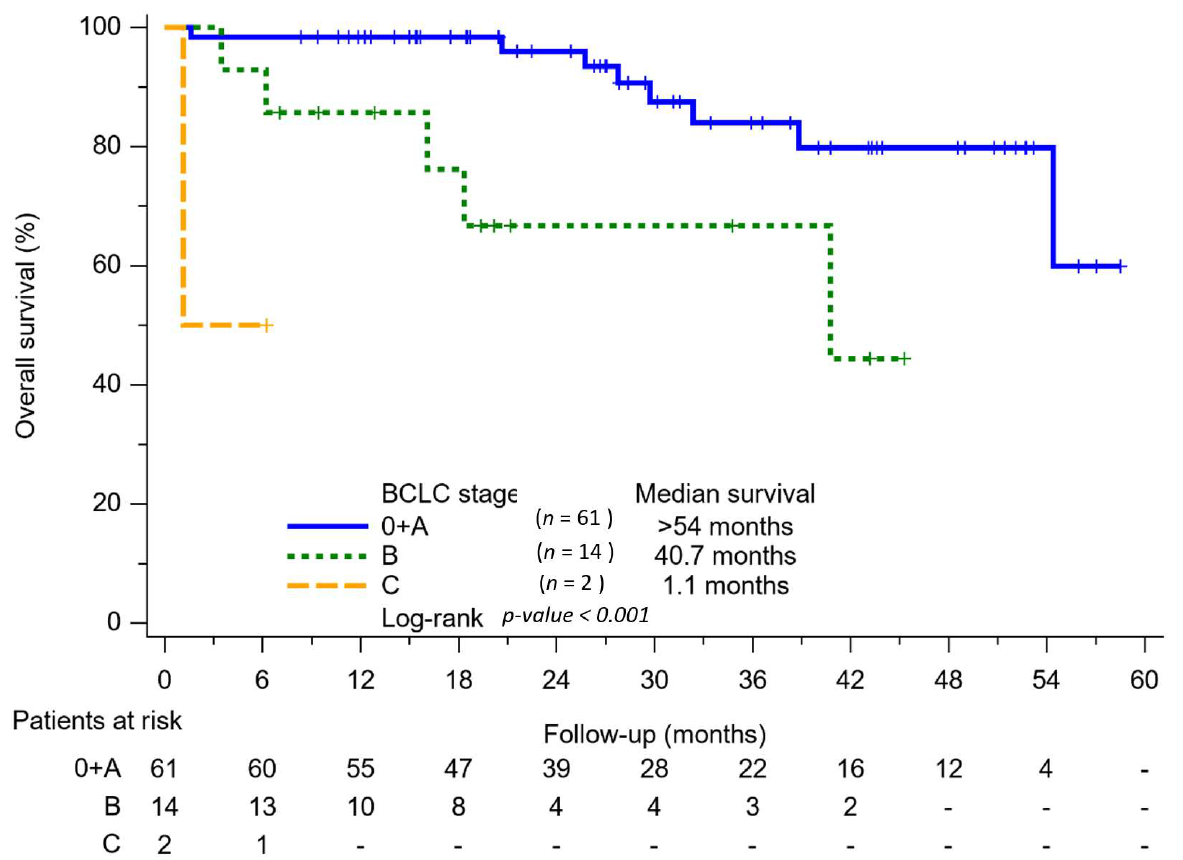
Figure 4. Kaplan–Meier analysis of overall survival among BCLC 0 + A, BCLC B and BCLC C patients.